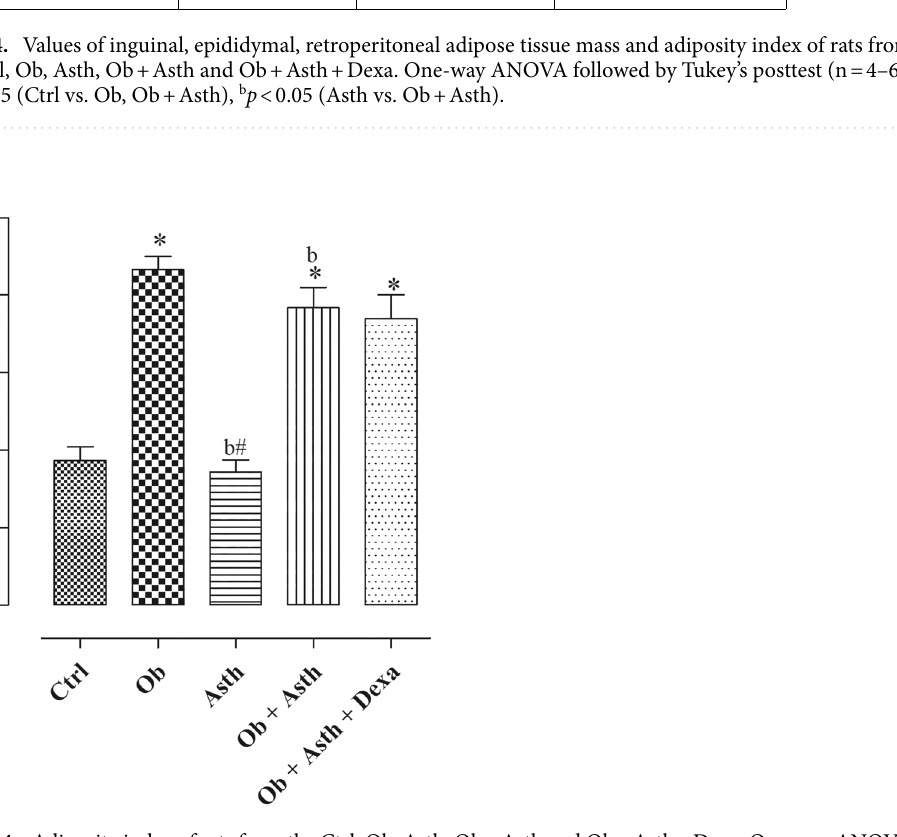
Figure 4. Adiposity index of rats from the Ctrl, Ob, Asth, Ob + Asth and Ob + Asth + Dexa. One-way ANOVA followed by Tukey’s posttest (n = 4–6). * p < 0.05 (Ctrl vs. Ob, Ob + Asth, and Ob + Asth + Dexa), b p < 0.05 (Asth vs. Ob +